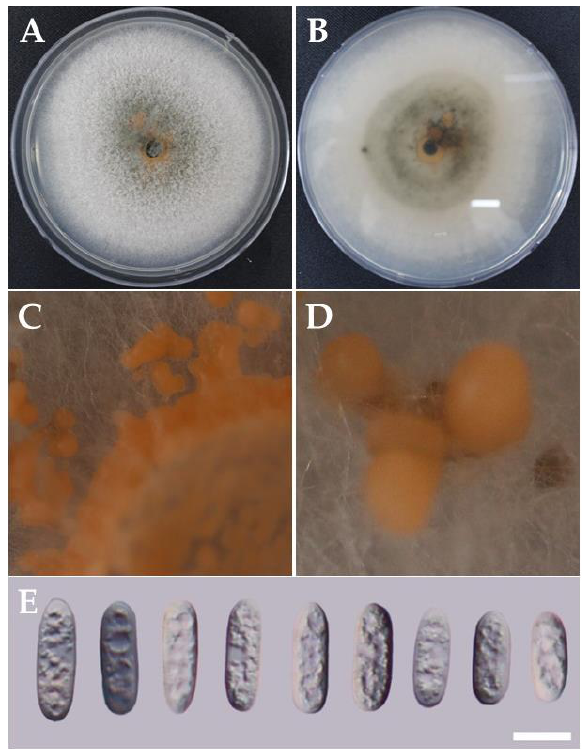
Figure 6. Colony characteristics of the isolate CMML20 – 11 on PDA at 25 °C for 7 days ( A – D ). A number of conidiomata under 20× magnification ( C , D ) and conidia ( E ) were observed under the microscope. Scale bars ( E ) = 10 μm.